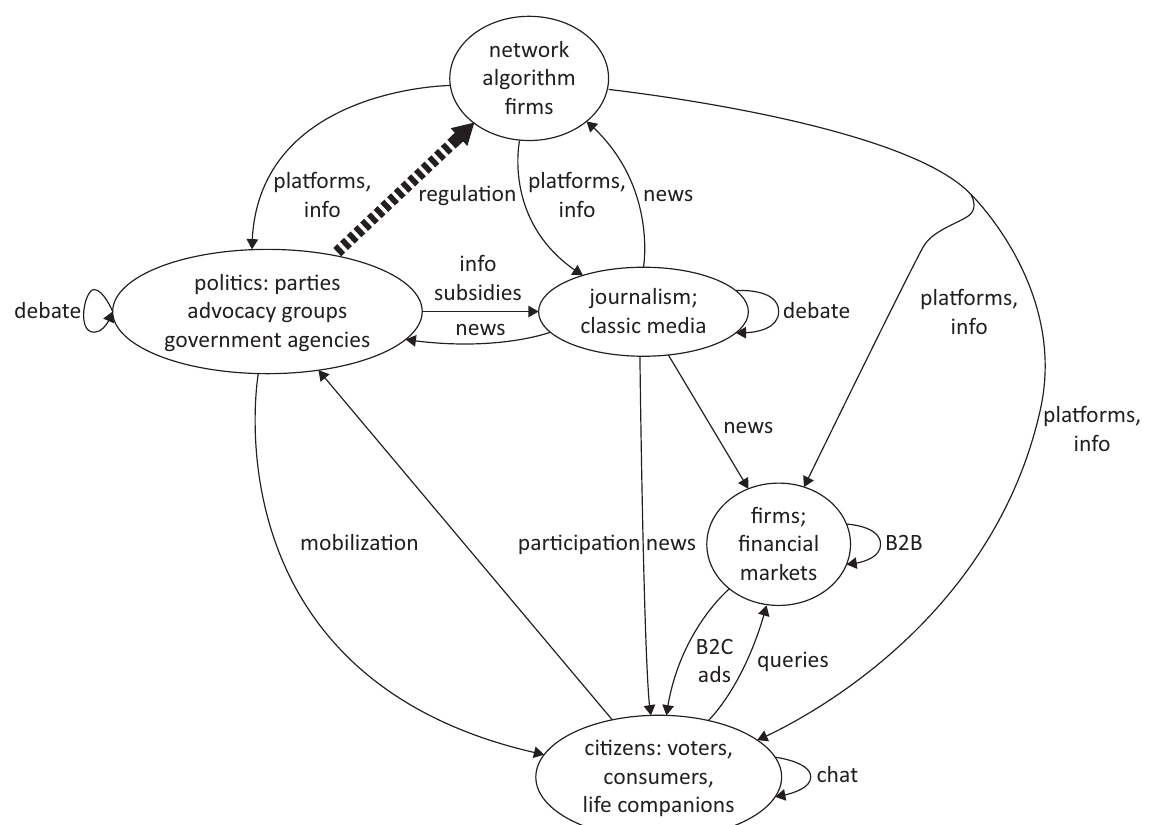
Figure 1. Reciprocal relations between network algorithm stakeholders in the market of news, ads, and